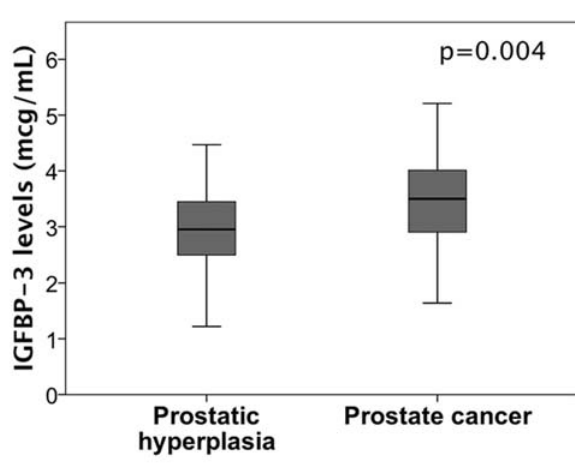
Figure 1 - Serum PSA levels (before surgery) in patients with prostatic hyperplasia and prostate cancer. Statistical significance was determined by Mann–Whitney’s test. The lower and upper bars represent the first and third quartiles respectively. The line across the box represents median value. The lines above and below the box represent the highest and lowest values, excluding outliers.